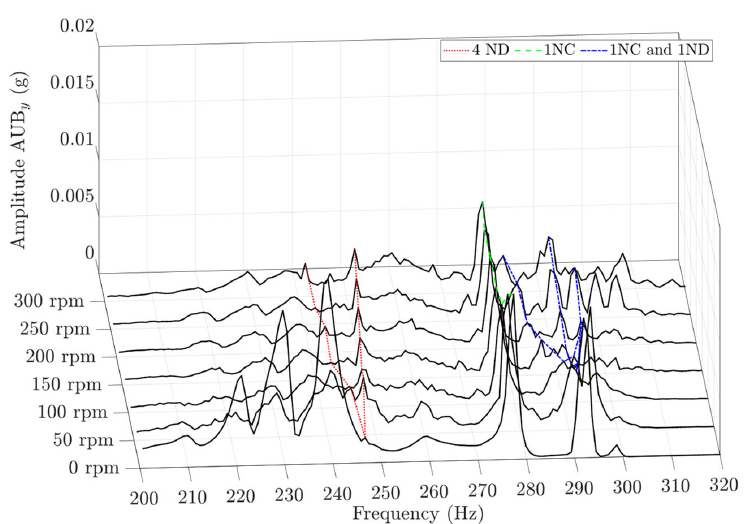
Figure 14. Maximum spectra of the STFT of the radial accelerometer, AUB y , when the disk was excited in air with a chirp in the range of 200 to 300 Hz at different rotating speeds.